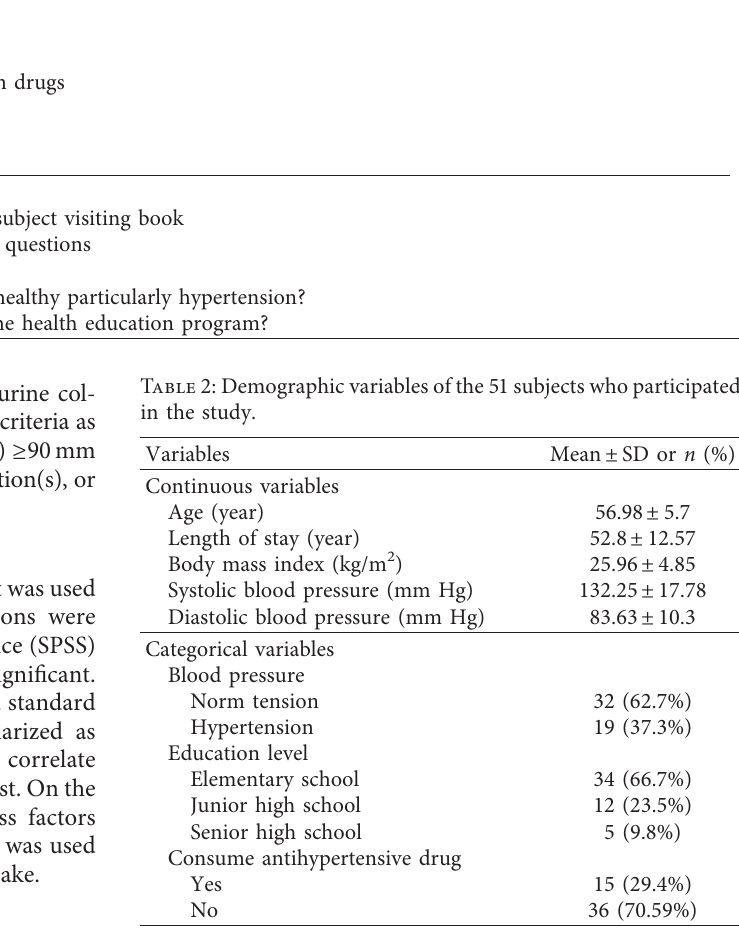
Table 3: Estimated salt intake from 24-h urinary stratified by Indonesian RDA and WHO and the correlation with blood